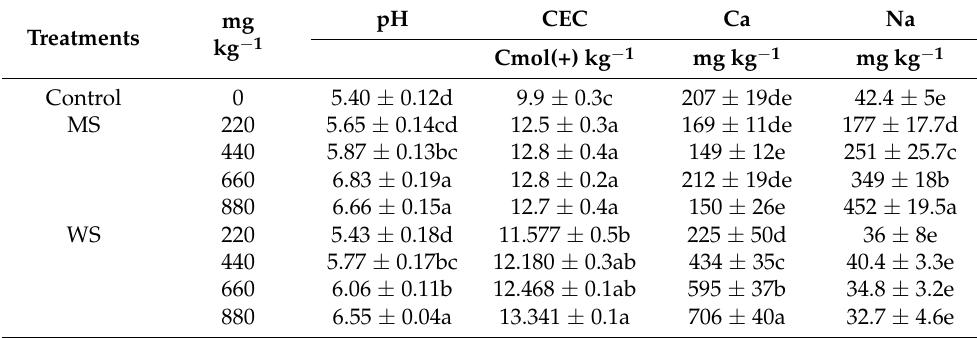
Table 3. Effects of different added dosages of Si on the pH values, CEC, and concentrations